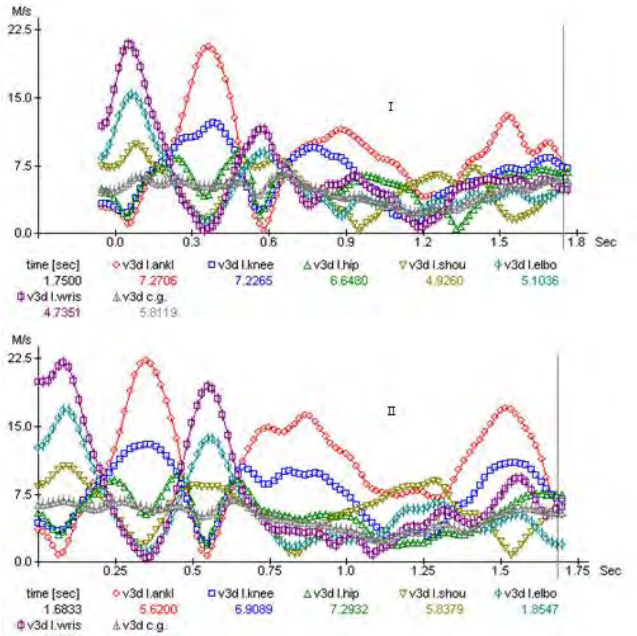
Fig. 8. Resultant speed values of ankle, knee, hip, shoulder, elbow and wrist joints, GMC in phase of final movements (FP) of grouped back double somersault after rondat (tested A, variant 1, upper section of figure, time 1. 750sec. ) and arched back double somersault after rondat – back turnover (tested B, lower section of figure, variant 2, time 1. 683